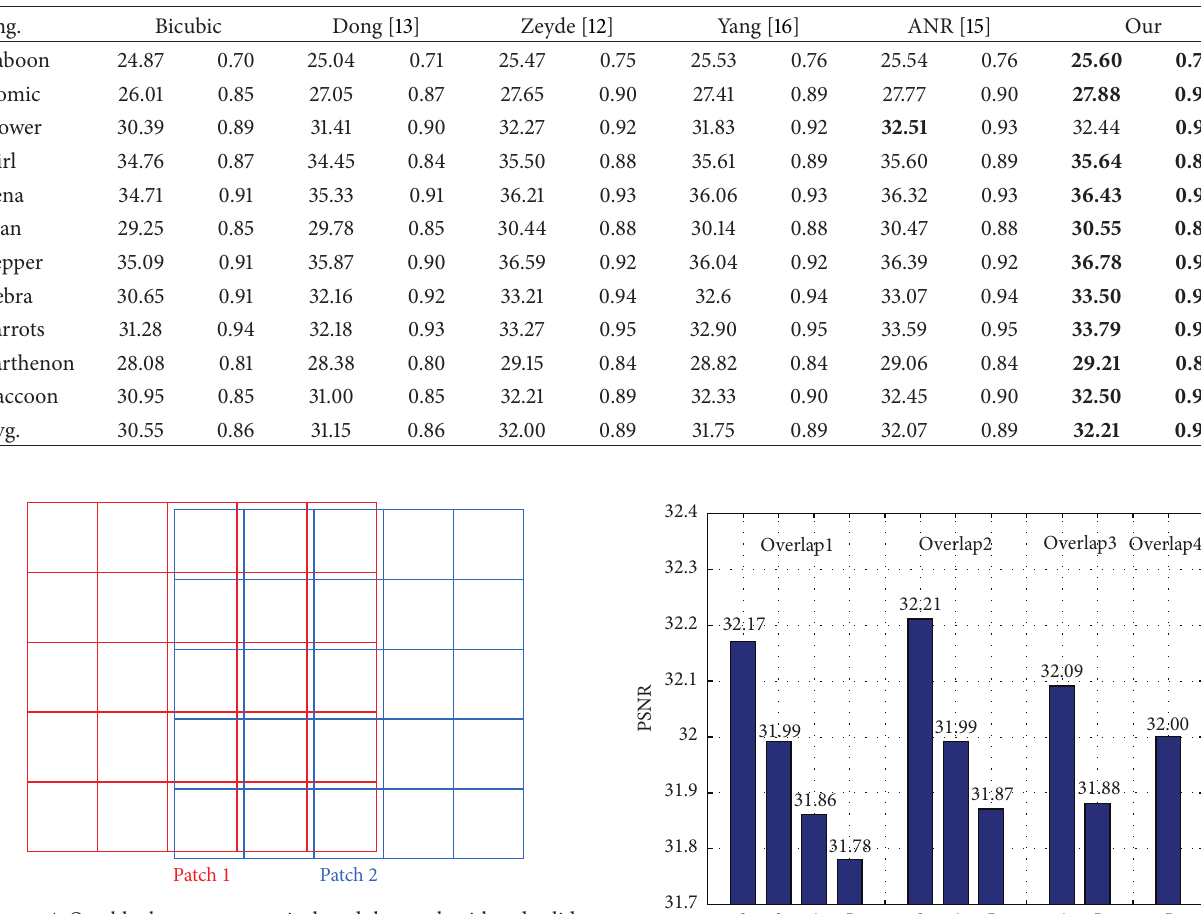
Figure 4: One block represents a pixel, and the patch with red solid curve is overlapped partitioned by the adjacent patch with blue solid curve. Theoverlapping pixels of each two adjacent patches are 2∗5 = 10 . Figure 5: The average PSNR values with respect to different patch sizes with different overlap